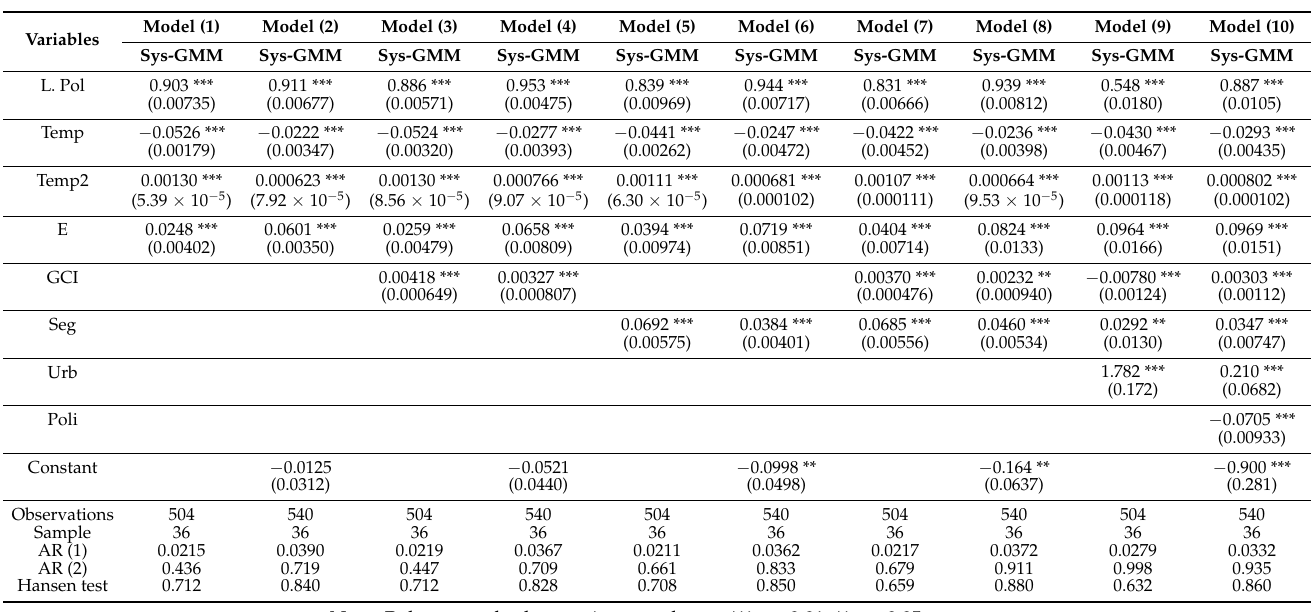
Table 8. The environmental pollution function